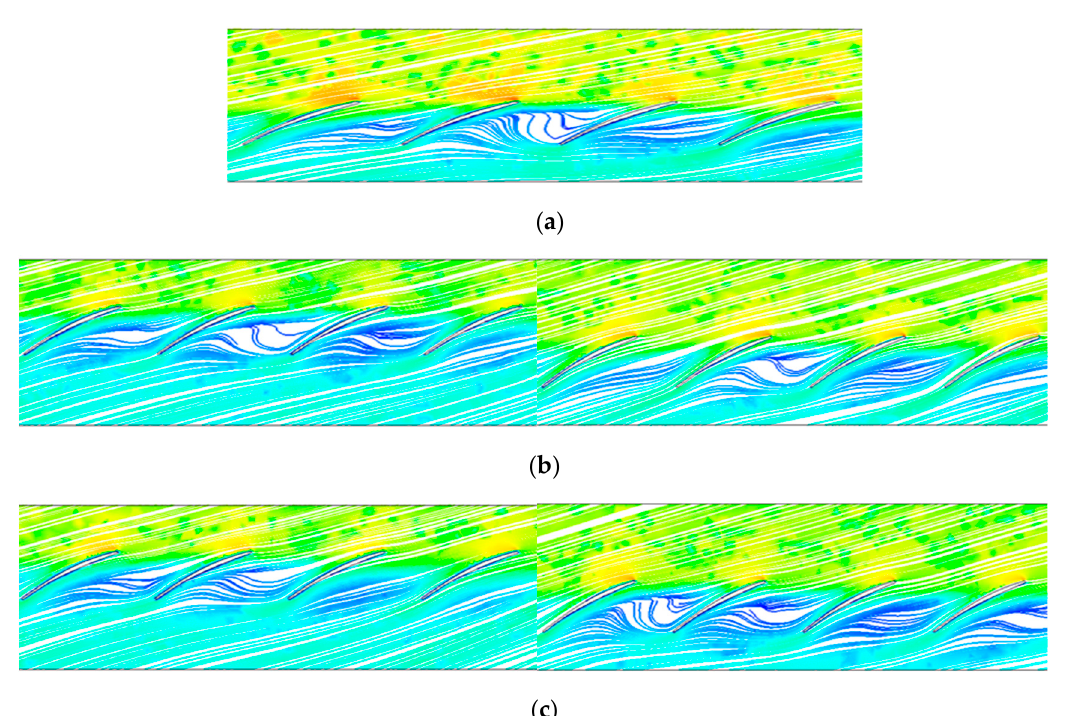
Figure 12. Streamline at the 95% radial blade height under three conditions: ( a ) No abnormal stagger angle; ( b ) abnormal stagger angle is − 6°; and ( c ) abnormal stagger angle is +6°.